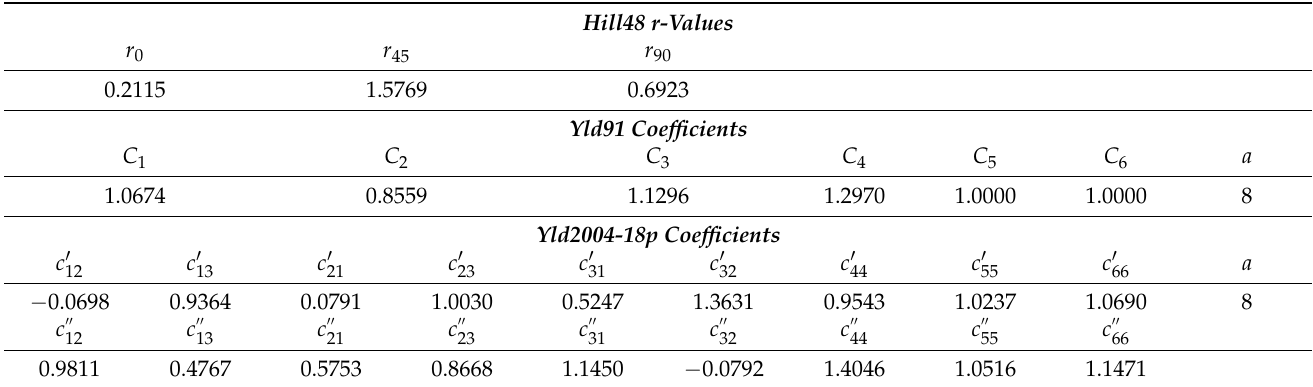
Table 2. Yield function coefficients of AA2090-T3 [33]. Adapted from Ref. [33] with permission from Elsevier (2021). Hill48 r-Values